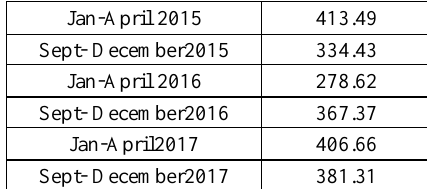
Table 1 . Mean velocities for each season from 2014 to 2017